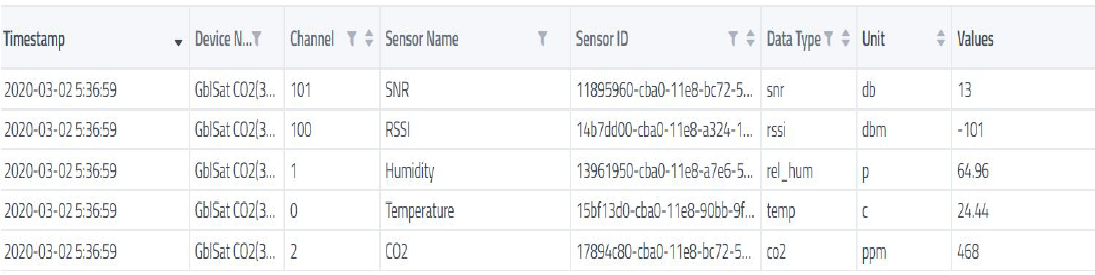
Figure 20. Sensors Information on application server from the gateway prototype: Sensor1.